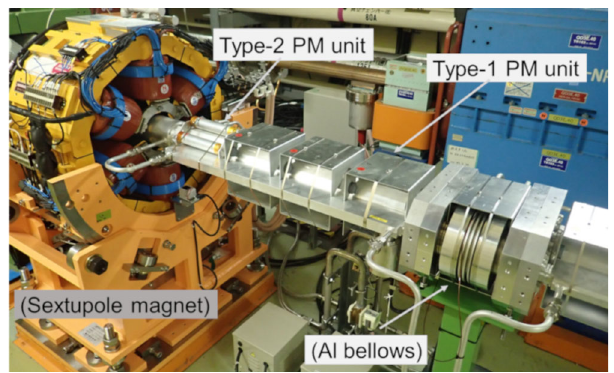
FIG. 21. PM units attached to an Al-alloy bellows chamber, and Type-1 and Type-2 PM units for beam pipes at drift spaces.